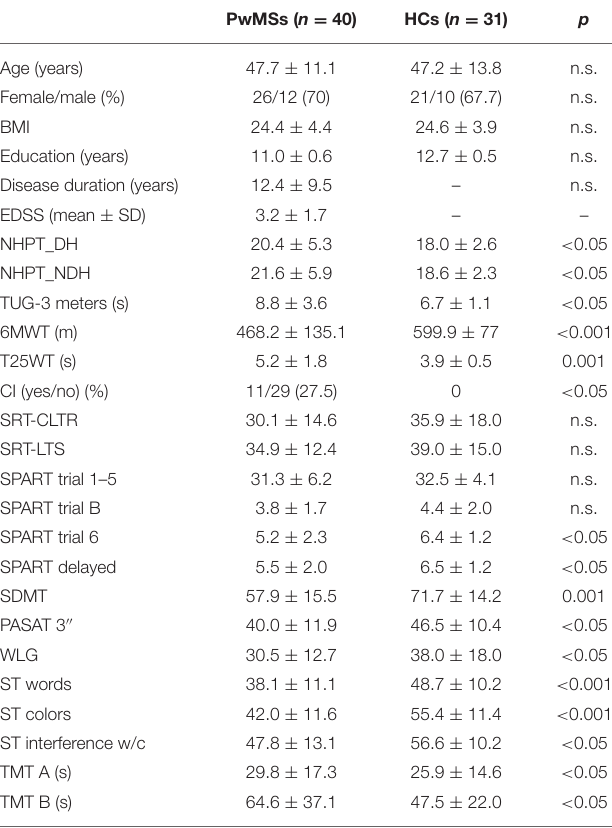
TABLE 1 | Demographic, physical, and cognitive baseline characteristics of pwMSs and